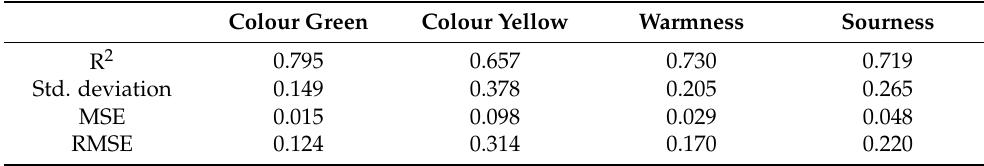
Figure 6. ( A , C ) show the standardised coefficients in the multiple linear regression for “tropical fruit” and “woody” flavours on Chardonnay wines. ( B , D ) show the predicted vs. experimental data graph for the multiple linear regression on the tropical fruit and woody flavours of Chardonnay wines. Table 7. Quality indexes of PLS regression model on Chardonnay visual and gustatory data. Colour Green Colour